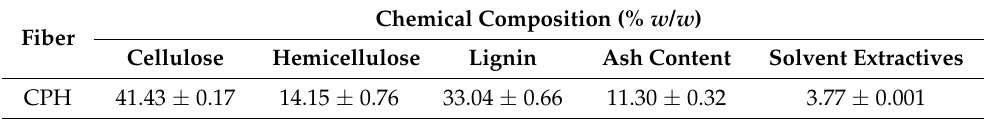
Table 1. Chemical composition of CPH